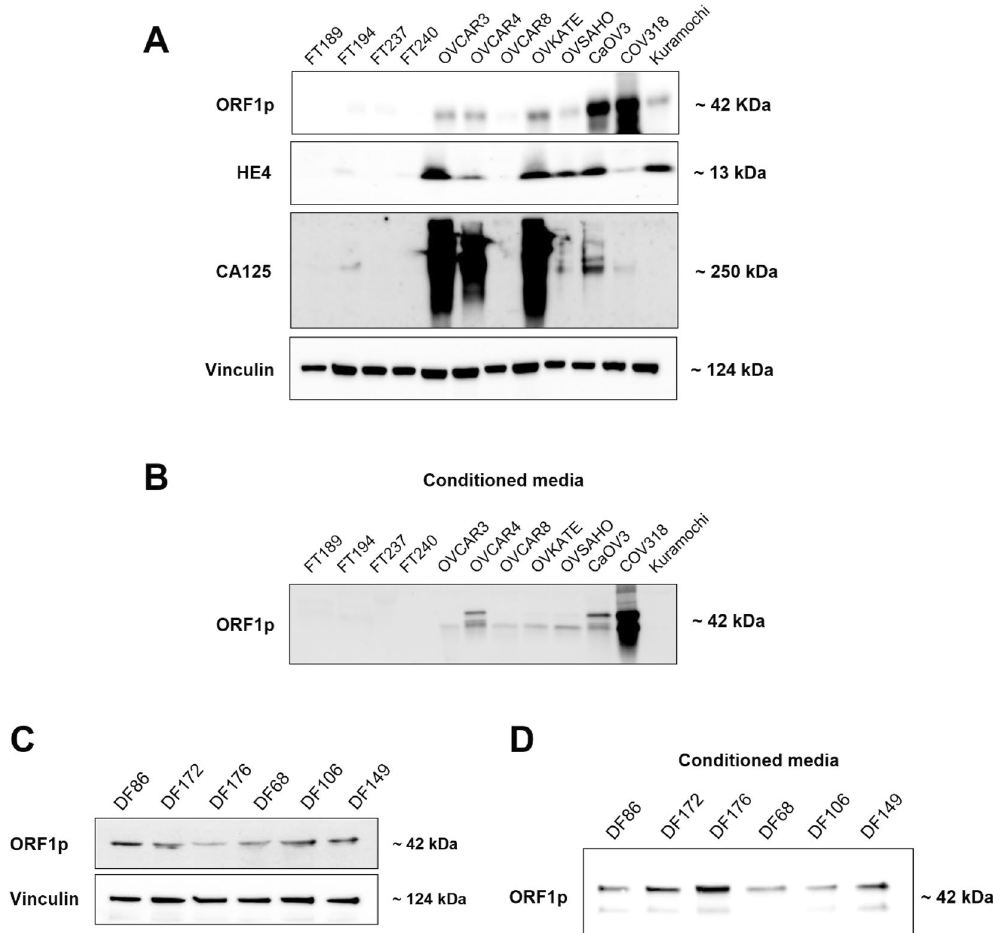
Figure 1. LINE1 ORF1p is detectable in conditioned media of HGSOC and is complementary to other known biomarkers. ( A ) Whole cell lysates. ORF1p, HE4, and CA125 protein expression (WB) in FT and HGSOC cell lines. Analyzed markers show differential expression between FT and HGSOC cells. Vinculin was used as internal control. ( B ) ORF1p protein expression (WB) in conditioned serum-free media from FT and HGSOC. ( C ) Whole cell lysate. ORF1p protein expression (WB) in six primary HGSOC cells derived from ascites fluid (DF cells). Vinculin was used as internal control. ( D ) ORF1p protein expression (WB) in primary HGSOC cells in conditioned serum-free